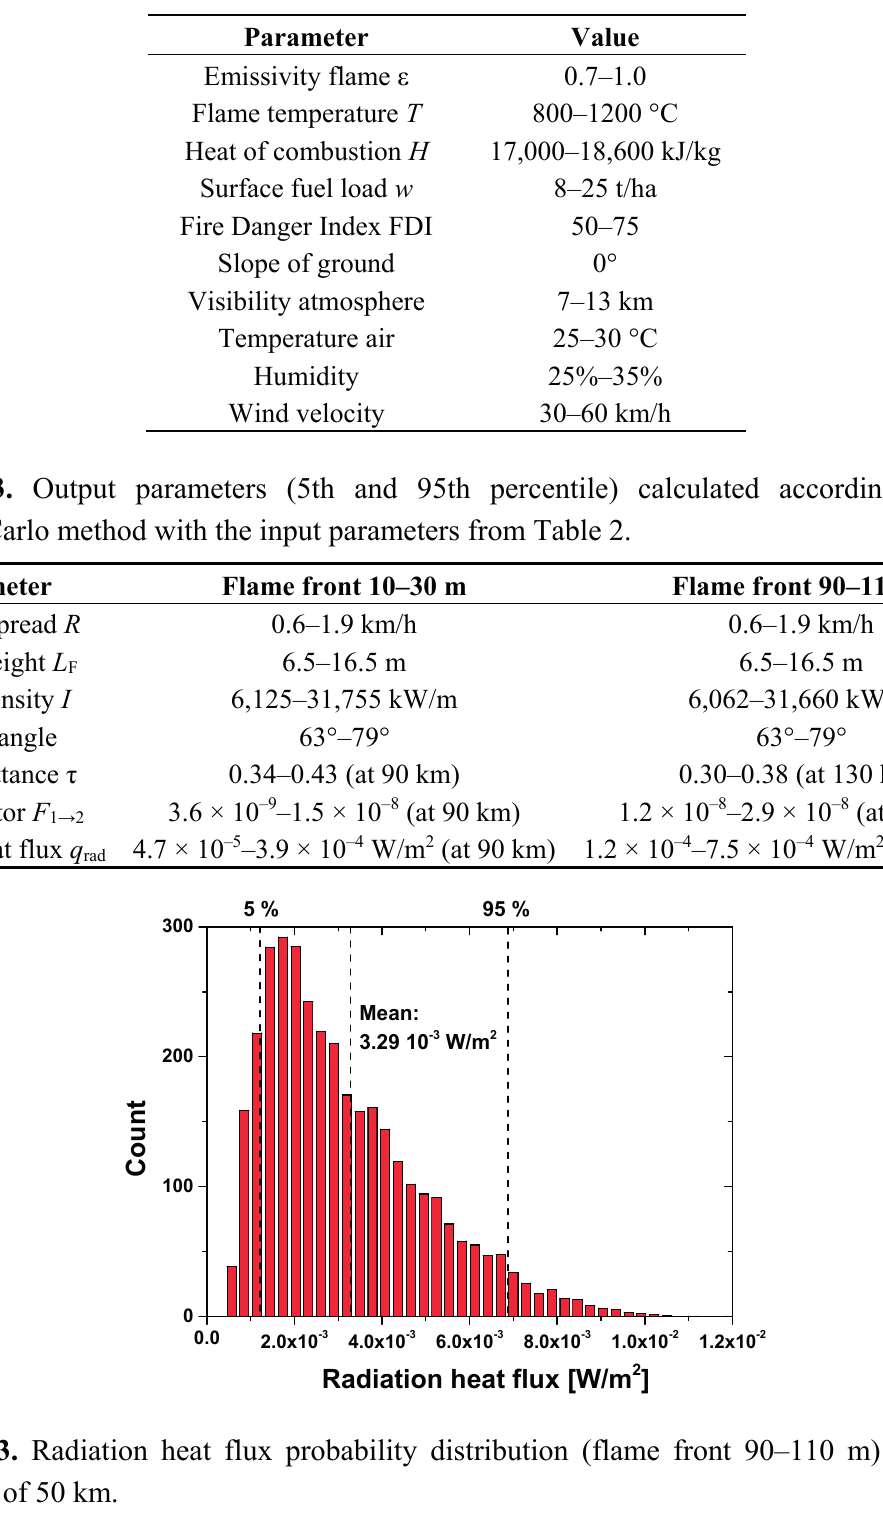
Table 2. Input parameters with uniform distribution for the Monte Carlo method.